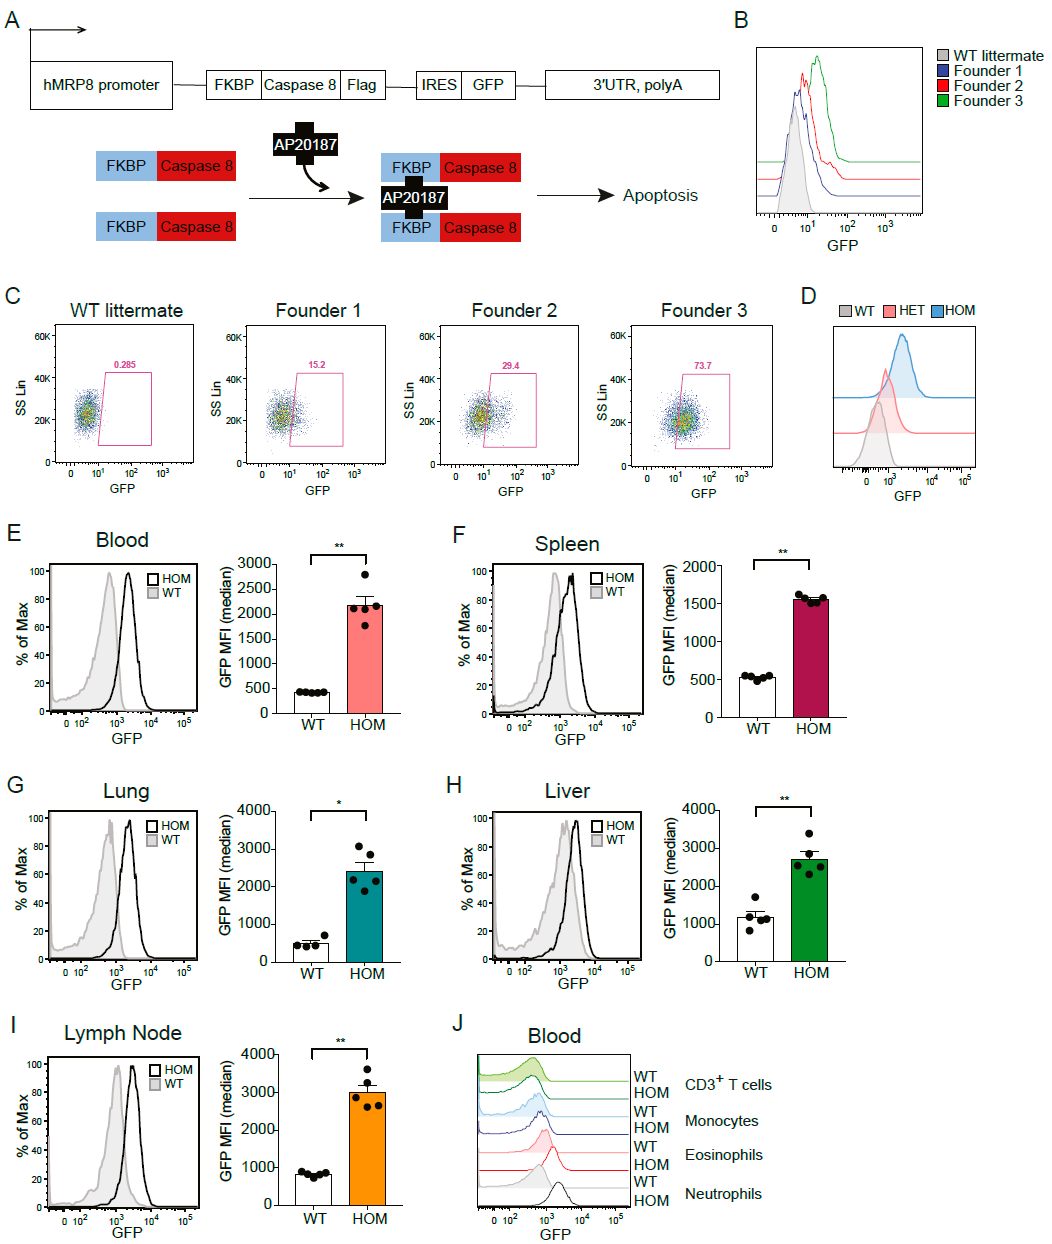
Figure 1. Generation and characterization of hMRP8-ATTAC mice. ( A ) Schematic representation of the ATTAC construct and the mechanism of apoptosis induced by the dimerizer AP20187. ( B , C ) Histograms and dot plots showing GFP expression in circulating neutrophils of four heterozygous hMRP8-ATTAC founders, as determined by flow cytometry. One of the founders does not carry the transgene as detected by PCR (WT littermate); the other three carry the transgene and express GFP at different levels (Founders 1, 2, 3). ( D ) Representative histograms of GFP expression in circulating neutrophils of heterozygous and homozygous hMRP8-ATTAC mice compared to WT littermates, as determined by flow cytometry. ( E – I ) Representative histograms of GFP expression and quantification of the Median Fluorescence Intensity (MFI) of GFP in neutrophils from blood ( E ), spleen ( F ), lung ( G ), liver ( H ), and lymph nodes ( I ) of homozygous hMRP8-ATTAC mice ( n = 5) compared to WT littermates ( n = 4–5), as determined by flow cytometry. ( J ) Representative histogram comparing GFP expression levels in circulating neutrophils, eosinophils, monocytes, and CD3 + T cells of homozygous hMRP8-ATTAC mice and WT littermates. WT, wild type; HET, heterozygous; HOM, homozygous. Data presented in E-I are mean values ± SEM. * p < 0.05, ** p < 0.01 by Mann–Whitney